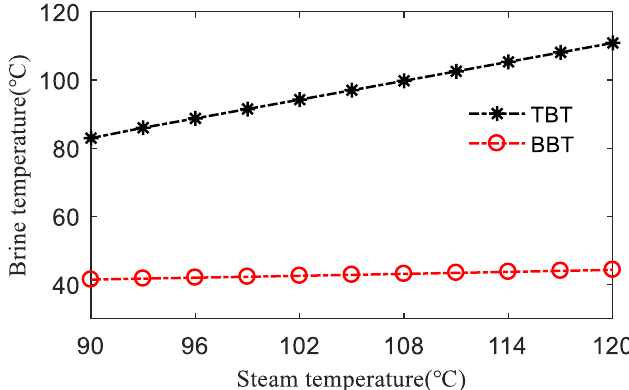
Figure 8. E ff ect of steam temperature ( T steam ) on brine temperature (TBT and Figure 8. Effect of steam temperature ( steam T ) on brine temperature (TBT and BBT).